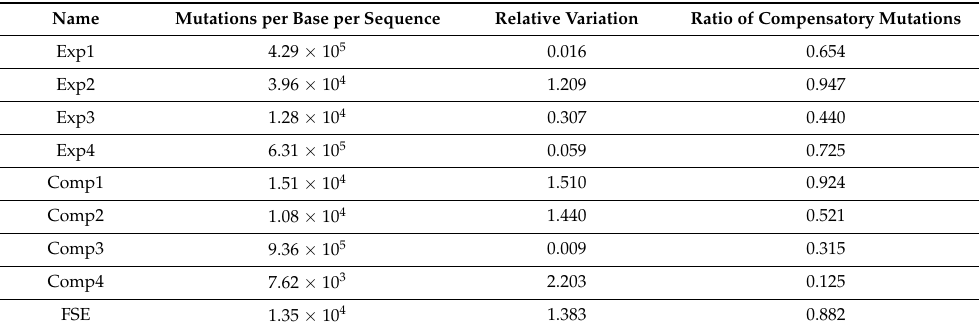
Table 4. Analysis of 8 RRI candidates across 32,714 SARS-CoV-2 genome sequences. Mutations per sequence were calculated and normalized by interacting sequence